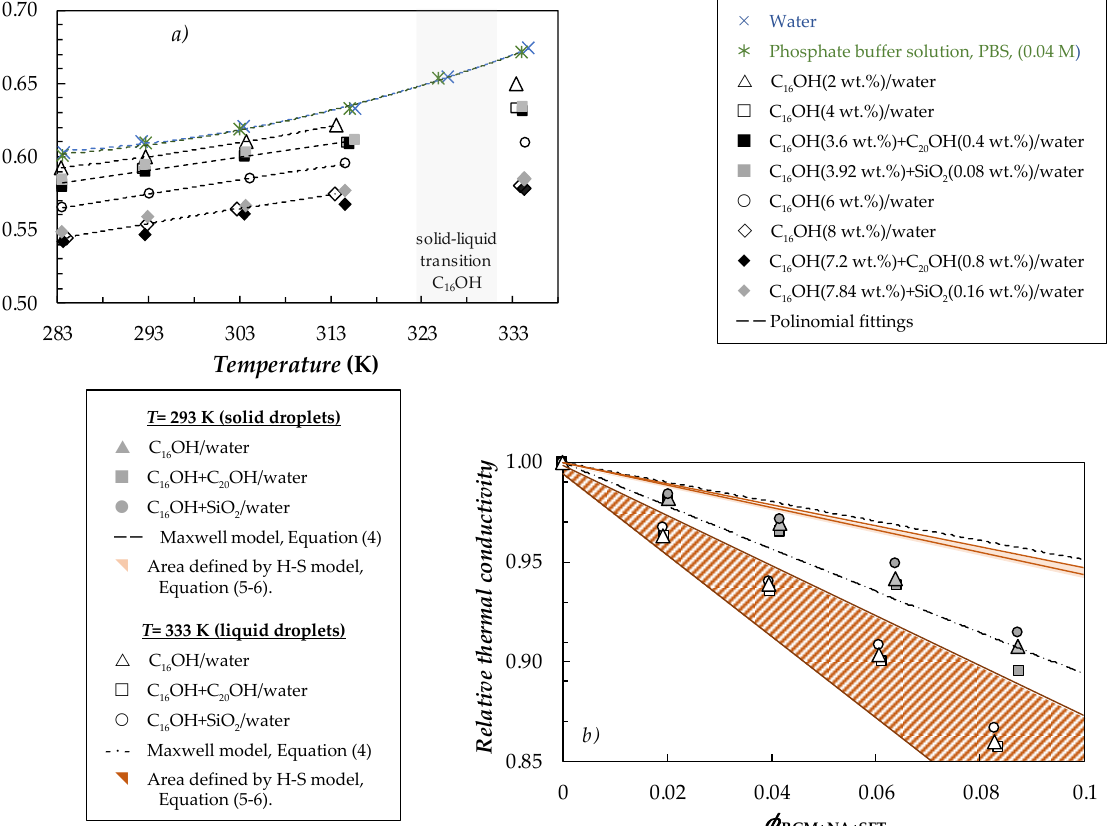
Figure 6. ( a ) Thermal conductivity vs. temperature for some representative emulsions and ( b ) volume fraction, ϕ PCM+NA+SFT , dependence of the relative thermal conductivity (defined as λ PCME /λ PBS ). Temperature uncertainty U ( T ): 0.1 K. Thermal conductivity uncertainty U ( 𝜆 ): 5%.